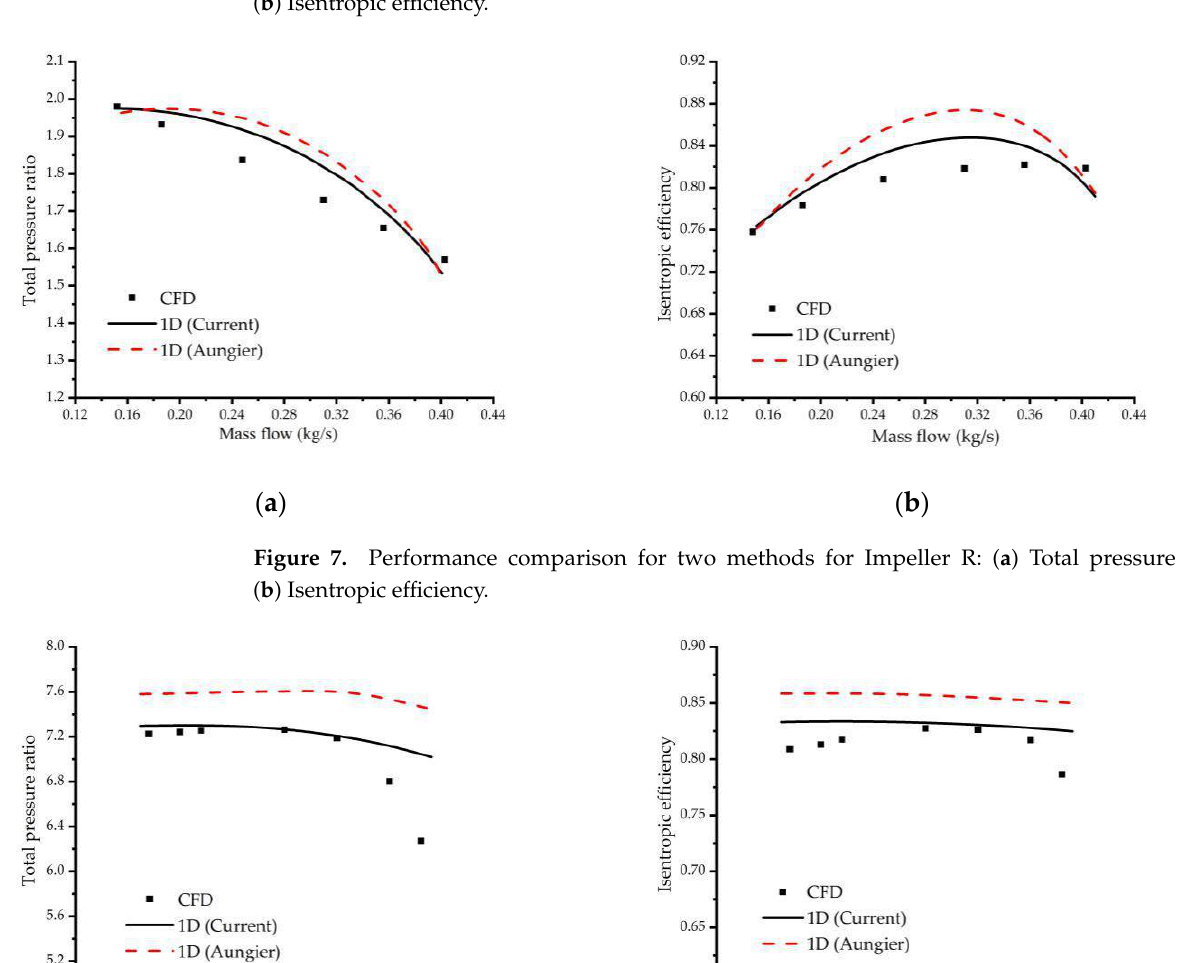
Figure 6. Performance comparison for two methods for the SRV2-O impeller: ( a ) Total pressure ratio; ( b ) Isentropic efficiency.